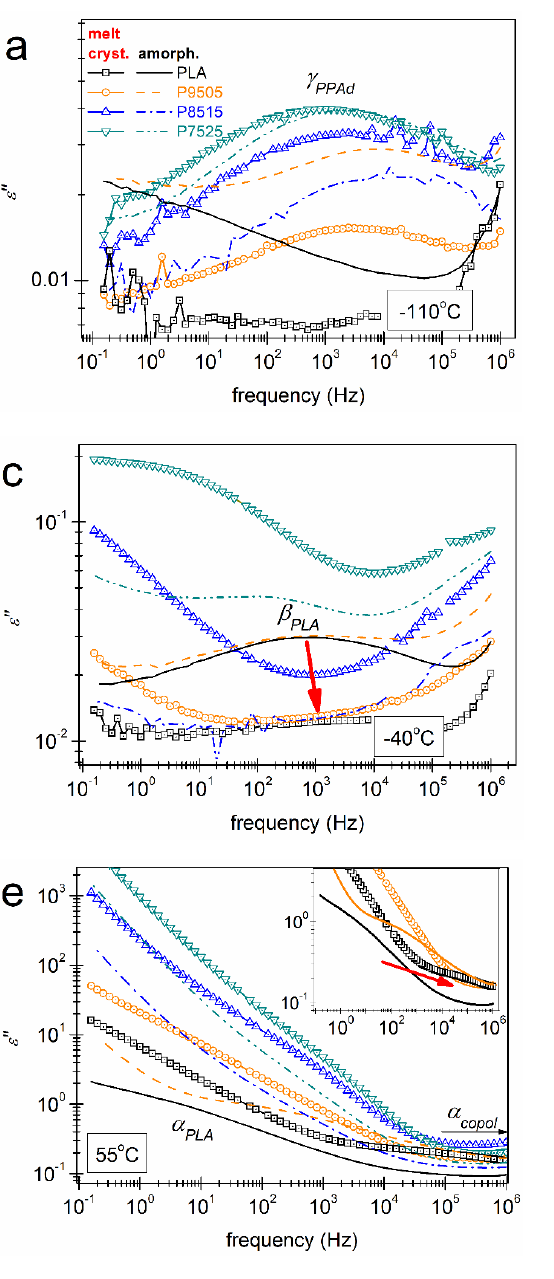
Figure 10. Isothermal spectra of ε″ ( f ) plots for all copolymers and neat PLA shown comparatively at various temperatures (indicated on the plots). The lines correspond to samples in the amorphous state, namely, melted and fast-cooled prior to the measurement, while the symbols connected with lines correspond to samples that had isothermally melt-crystallized at T anneal,mc prior to the BDS measurement. The added red arrows mark the effects imposed by the implementation of crystallinity.